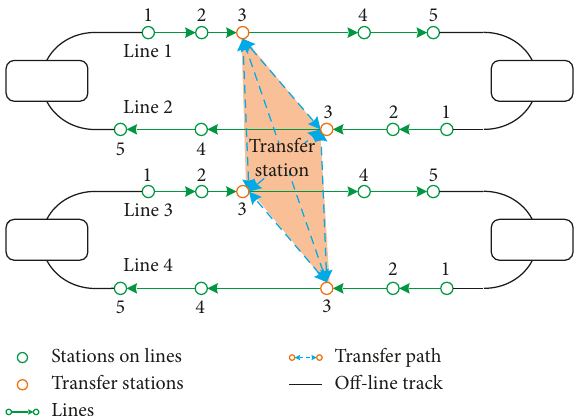
Figure 4: Illustration of the numerical case rail transit